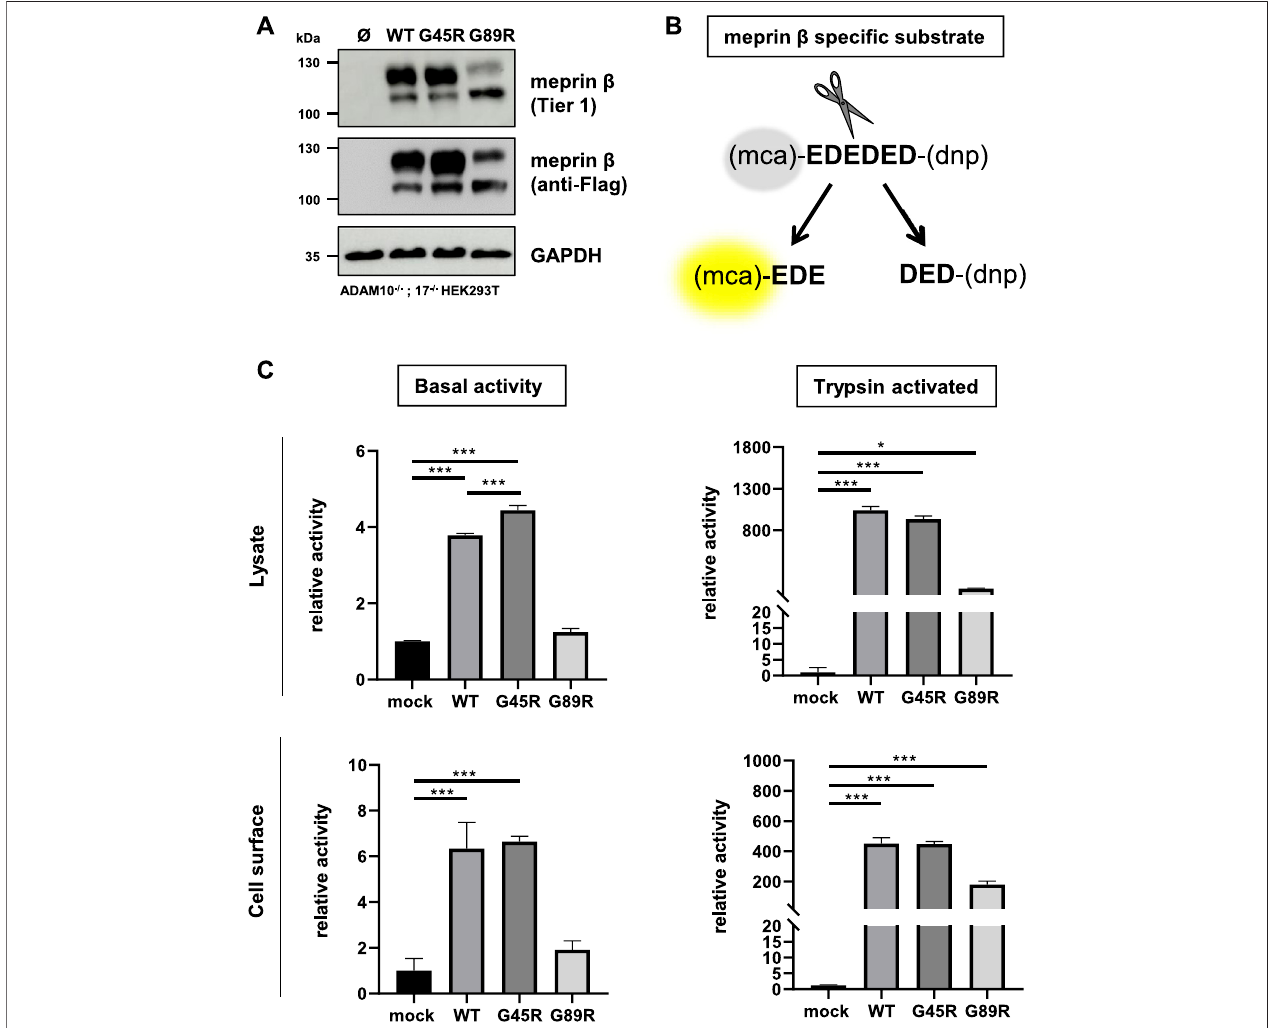
FIGURE2| ProteolyticactivityofG45R,G89R,andwild-typemeprin β towarda fl uorogenicpeptide.ADAM10 − / − ;17 − / − HEK293Tcellsweretransientlytransfected with a control plasmid (Ø) or one of the indicated meprin β variants. (A) Representative Western blot analysis of cell lysates. (B) Representation of the meprin β -speci fi c quenched fl uorogenic peptide used for activity assays. (C) Cell lysate and cell surface meprin β activity in the absence and presence of trypsin. Data are presented as means ± sd, and statistical analysis was assessed by the one-way ANOVA followed by Tukey ’ s post-test from three biological replicates. * p < 0.05, ** p < 0.01, *** p < 0.001.